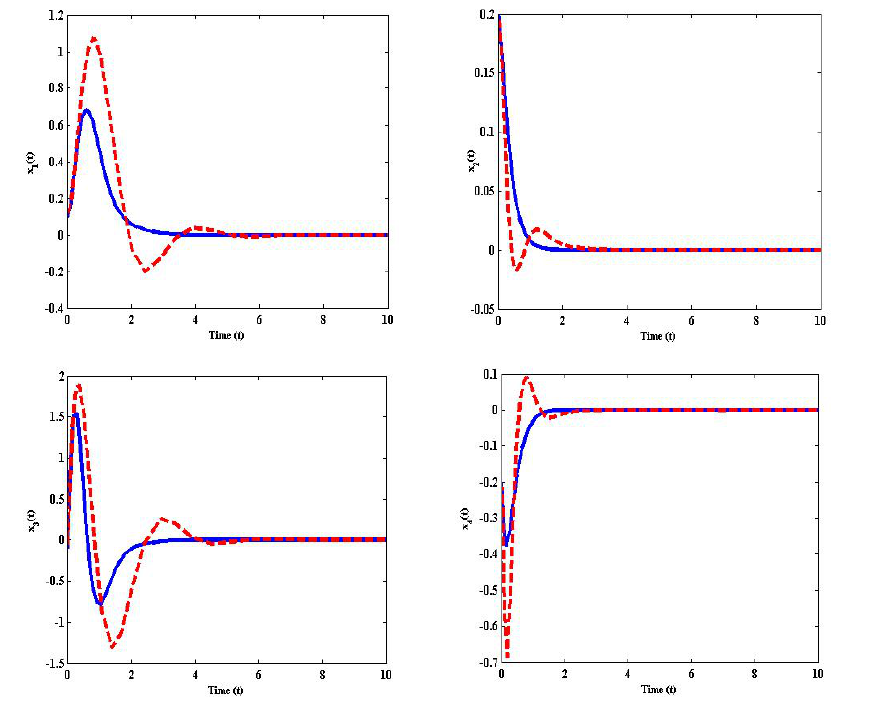
Figure 2. Displacement trajectories of controlled and uncontrolled for nominal system